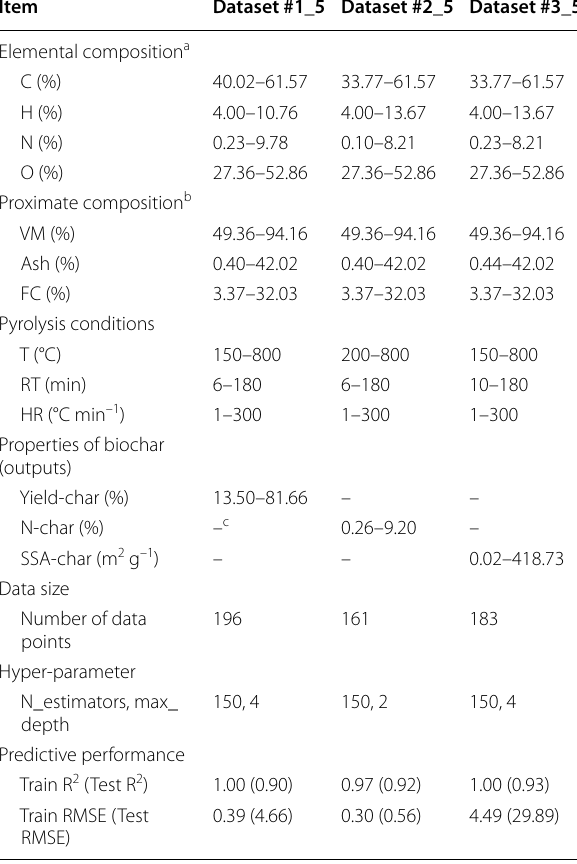
Table 3 The parameter scale of the elemental composition, the proximate composition and the pyrolysis conditions for single- target cases in GBR